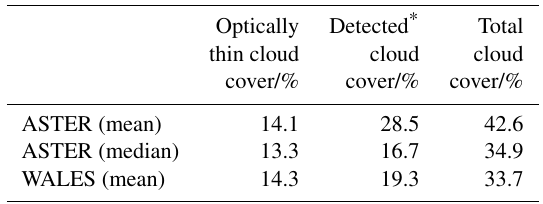
Table 2. Cloud cover estimates during EUREC 4 A from 380 ASTER satellite observations (60 × 60km 2 ) at 15m resolution on 17d and from WALES lidar measurements recoded within 13 re- search flights (days) at about 40m resolution in January and